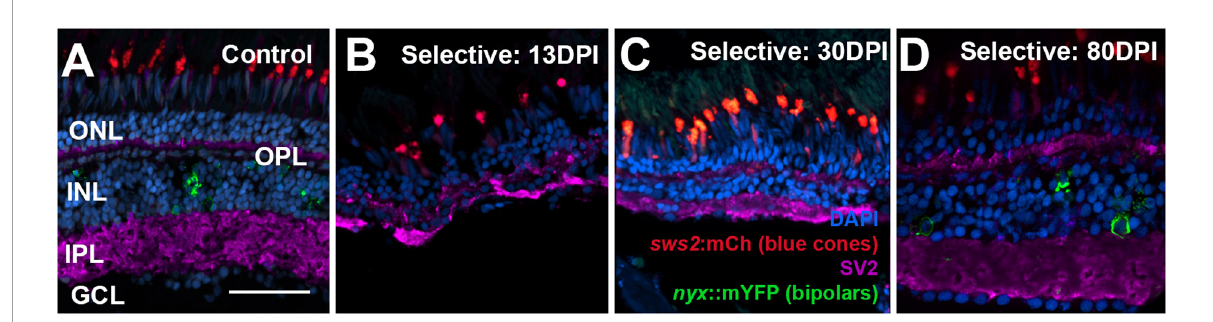
FIGURE10 Time-course of restoration of SV2 + plexiform layers following selective lesion. Tissues were processed for indirect immunofluorescence and imaging after ERG recordings. (A) Control retina showing SV2 staining within the outer plexiform layer (OPL) and inner plexiform layer (IPL). (B–D) Regenerating retinas at 13 (B) , 30 (C) , and 80 days post-injury (DPI) (D) . SV2 staining is visible but disorganized within an emerging OPL and IPL at 13 DPI (B) , but displays improved lamination at 30 and particularly at 80 DPI (C,D) . ONL, outer nuclear layer; INL, inner nuclear layer; GCL, ganglion cell layer; scale bar (in A , applies to all) = 50 µ